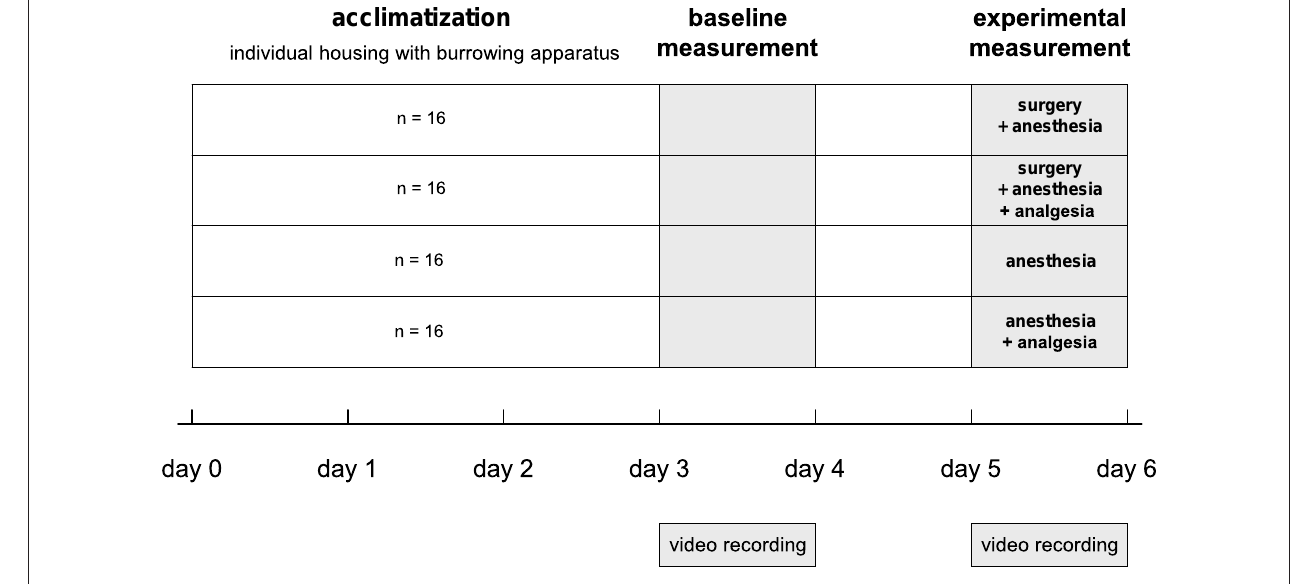
Figure 2 | experimental design and chronological order of experimental procedures and behavioral